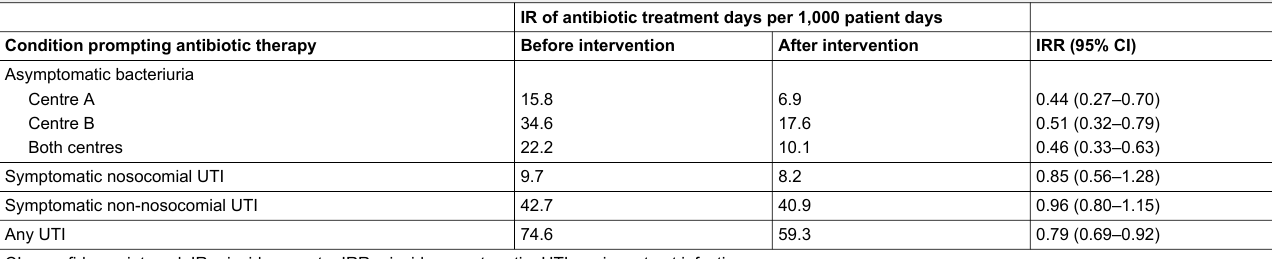
Table 3: Antibiotic use for urinary tract infections in treatment days per 1,000 patient days. IR of antibiotic treatment days per 1,000 patient